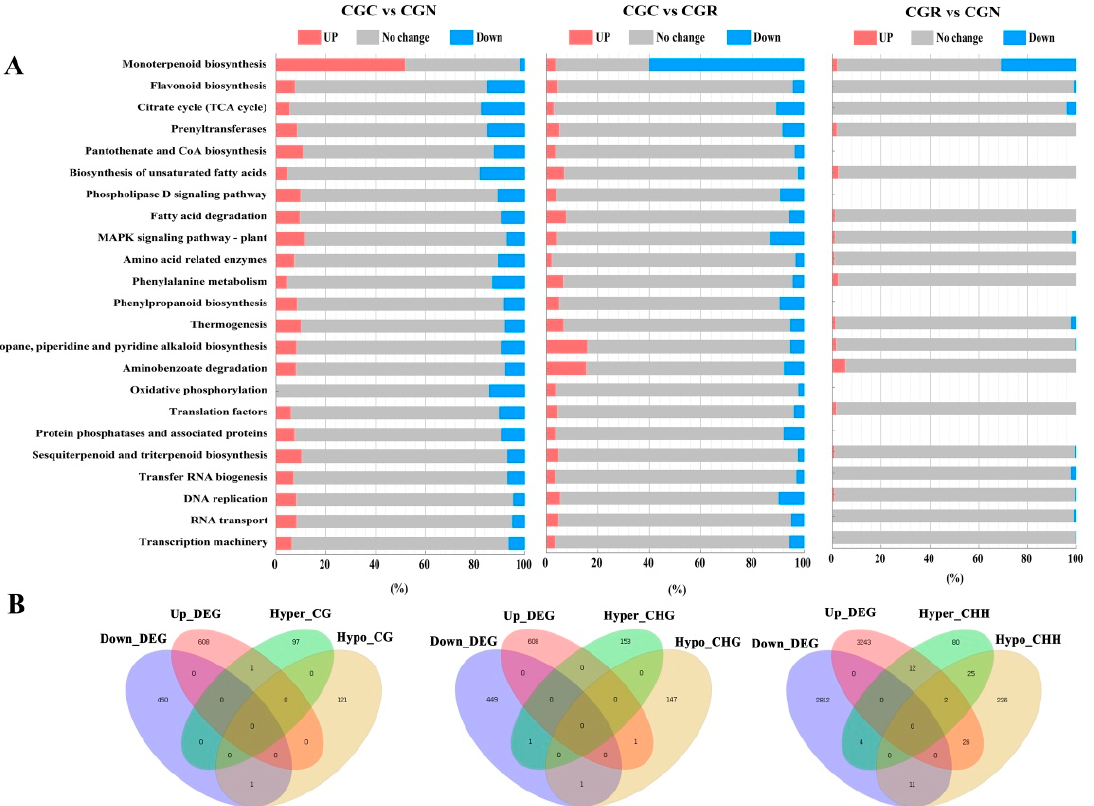
Figure 5. Functional categories of DEGs and Overlap Numbers of DMRs. ( A ) Quantitative patterns of DEGs belonging to specific functional categories defined by MapMan BINs. CGC: plants stored at 6 ◦ C for 24 h. CGR: plants stored at 6 ◦ C for 24 h and then transferred to 20 ◦ C for a 24 h recovery period. CGN: plants grown under normal (25 ◦ C) conditions. The genes in the red BINs are significantly upregulated, the expression of those in the gray BINs is not significantly different, and the genes in the blue BINs are downregulated. ( B ) Numbers of overlapping regions of hypermethylated and hypomethylated-DMRs in the up- or down-regulated DEGs.